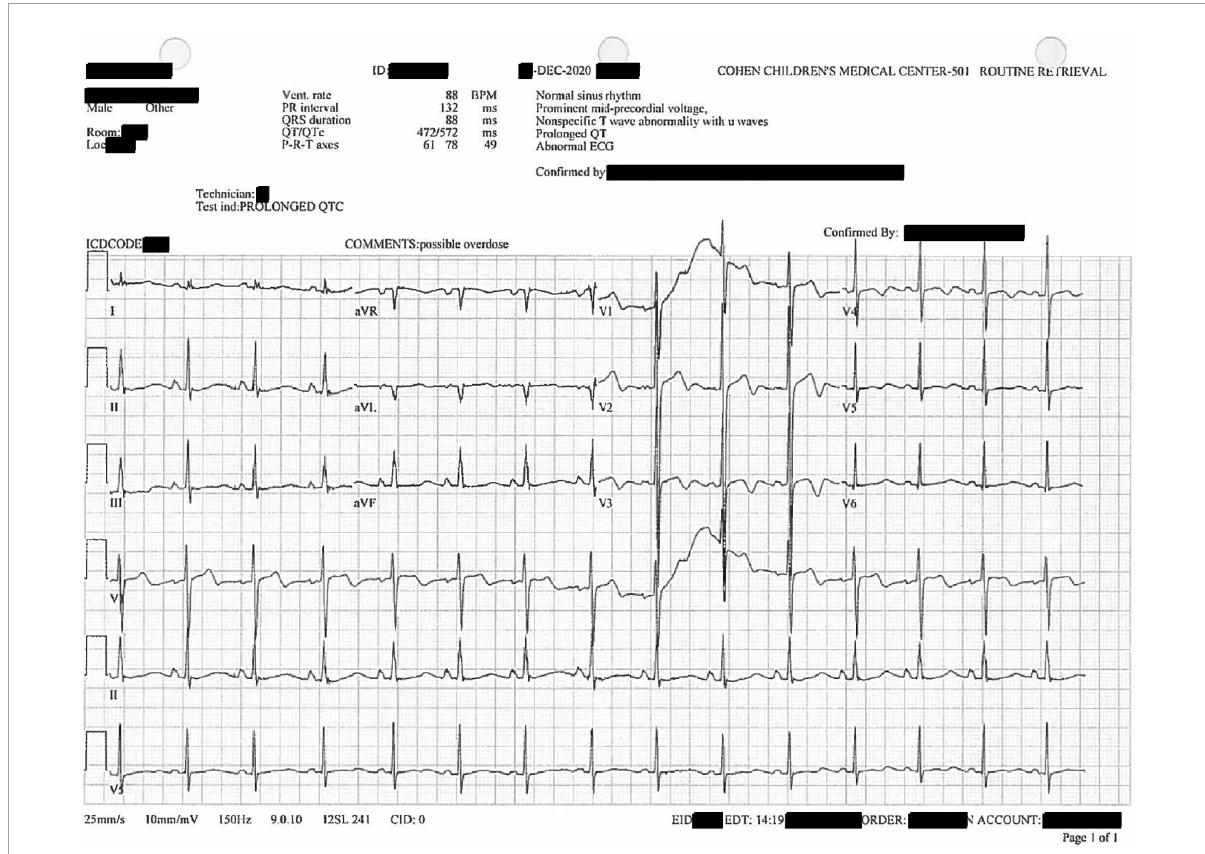
FIGURE2 Twelve-lead diagnostic electrocardiogram collected after the patient’s initial hospitalization. U waves noted in V1–V4. Prolonged QTc of 572